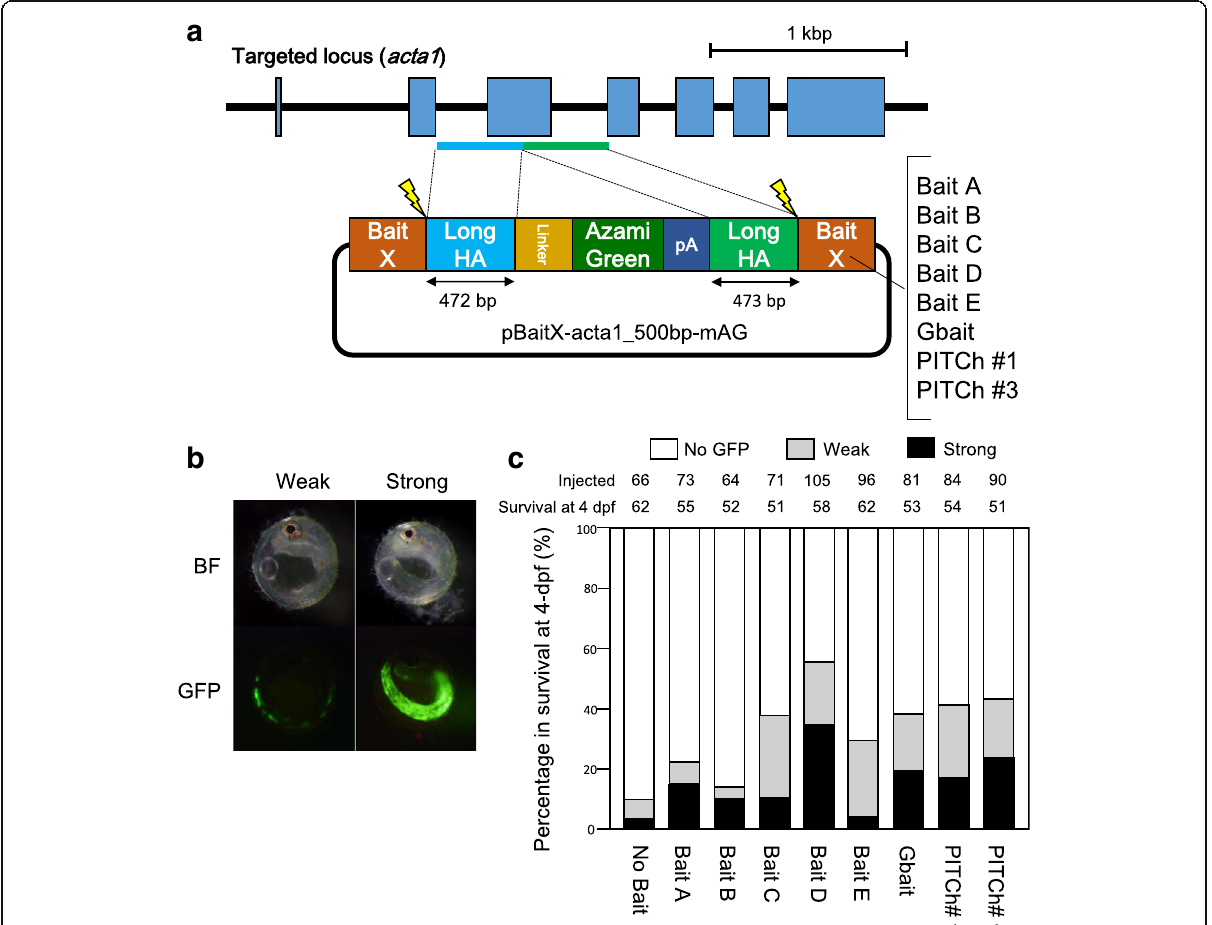
Fig. 2 Comparison of the efficiencies of targeted gene integration among bait sequences. (a) Schematic illustration of the genomic targeted locus, acta1 , and donor plasmids containing each bait sequence. Long homology arms (Long HAs) are shown in boxes with light blue or green. (b) Representative GFP expression in injected embryos at four days post fertilization (dpf). The injected embryos are categorized by GFP expressing area into the following three groups; “ No GFP ” , “ Weak ” , or “ Strong ” with no fluorescence, less than 40% fluorescence, or more than 40% fluorescence of the skeletal muscle, respectively. (c) Evaluation of the efficiencies of targeted gene integration of donor vectors with various bait sequences. The number of injected eggs is shown as “ Injected ” , and the number of survived embryos at 4-days post fertilization (dpf) among the injected eggs is shown as “ Survival at 4 dpf